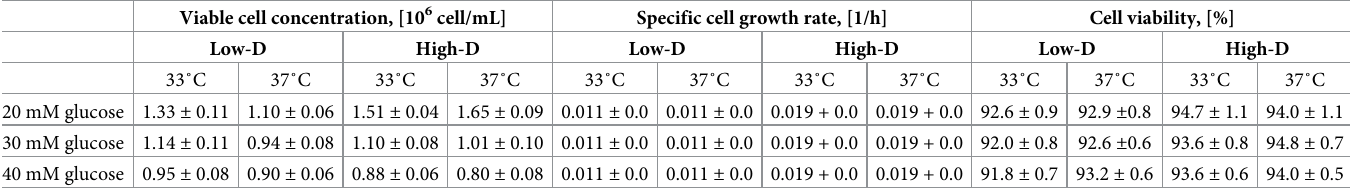
Table 1. Viable cell concentration and viability in CHO cell chemostat cultures at steady state. Viable cell concentration, [10 6 cell/mL] Specific cell growth rate, [1/h] Cell viability, [%]